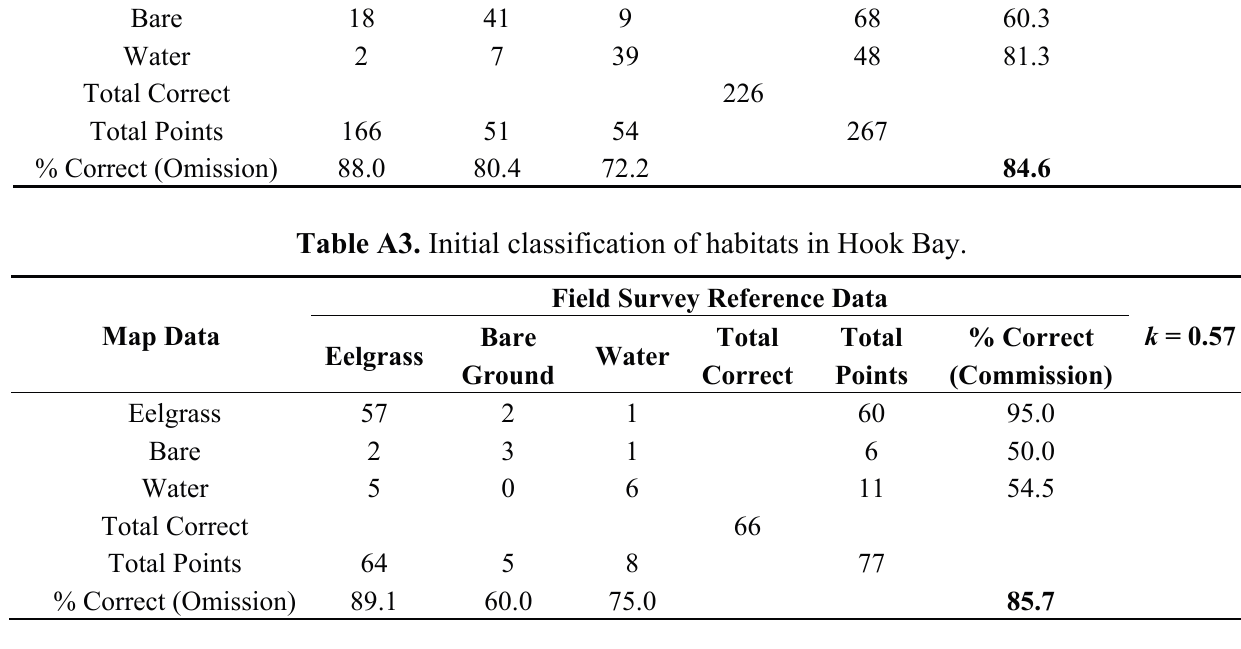
Table A4. Final product for classification of habitats in Hook Bay.